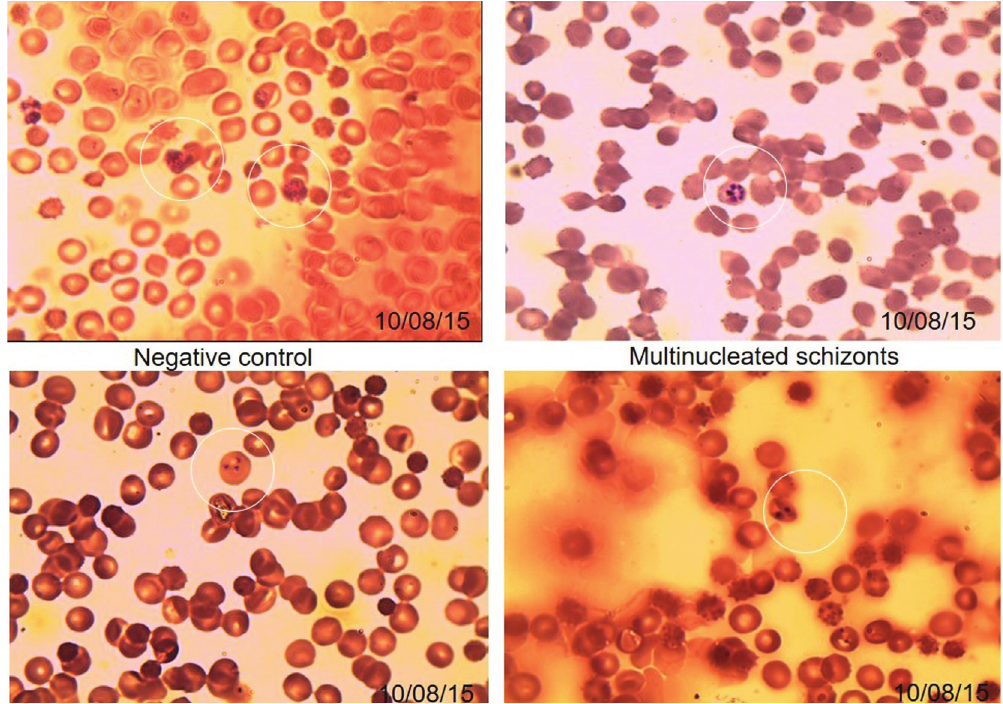
FIGURE 6 - Drug treated parasite